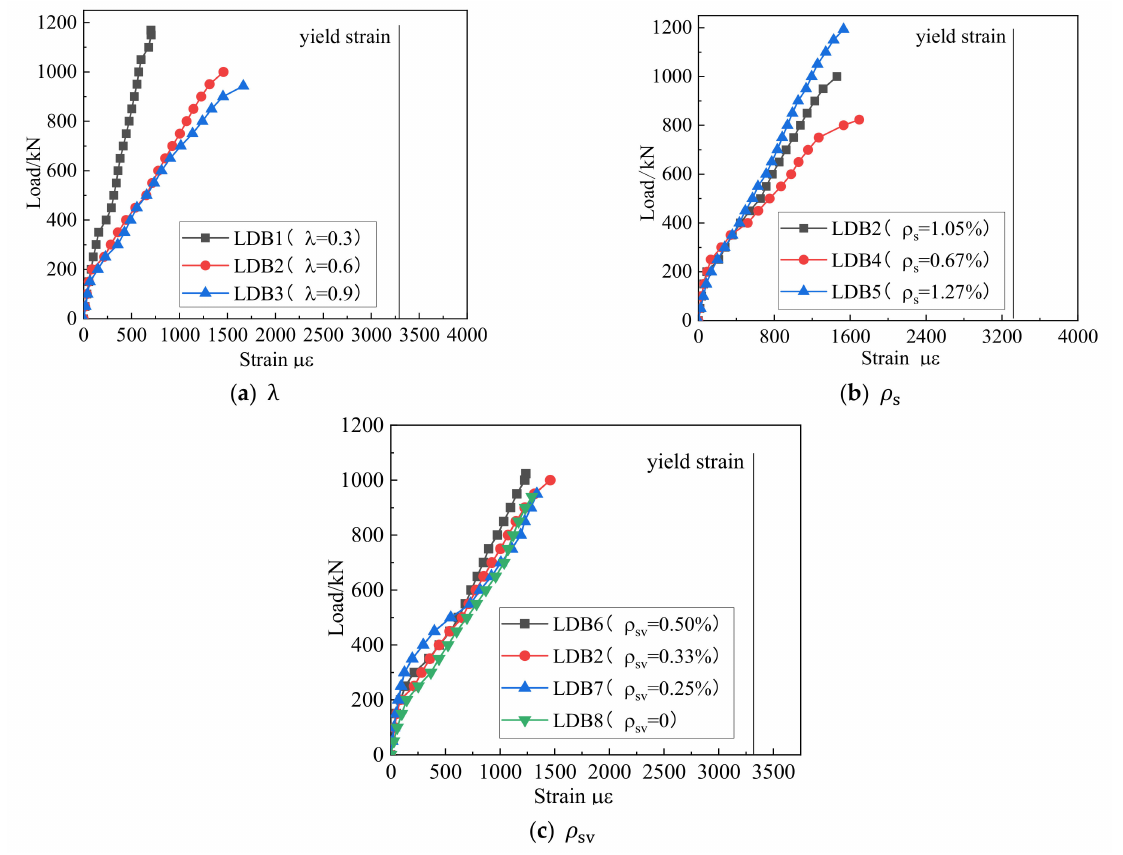
Figure 15. Relation curve between the three variables and longitudinal reinforcement strain.